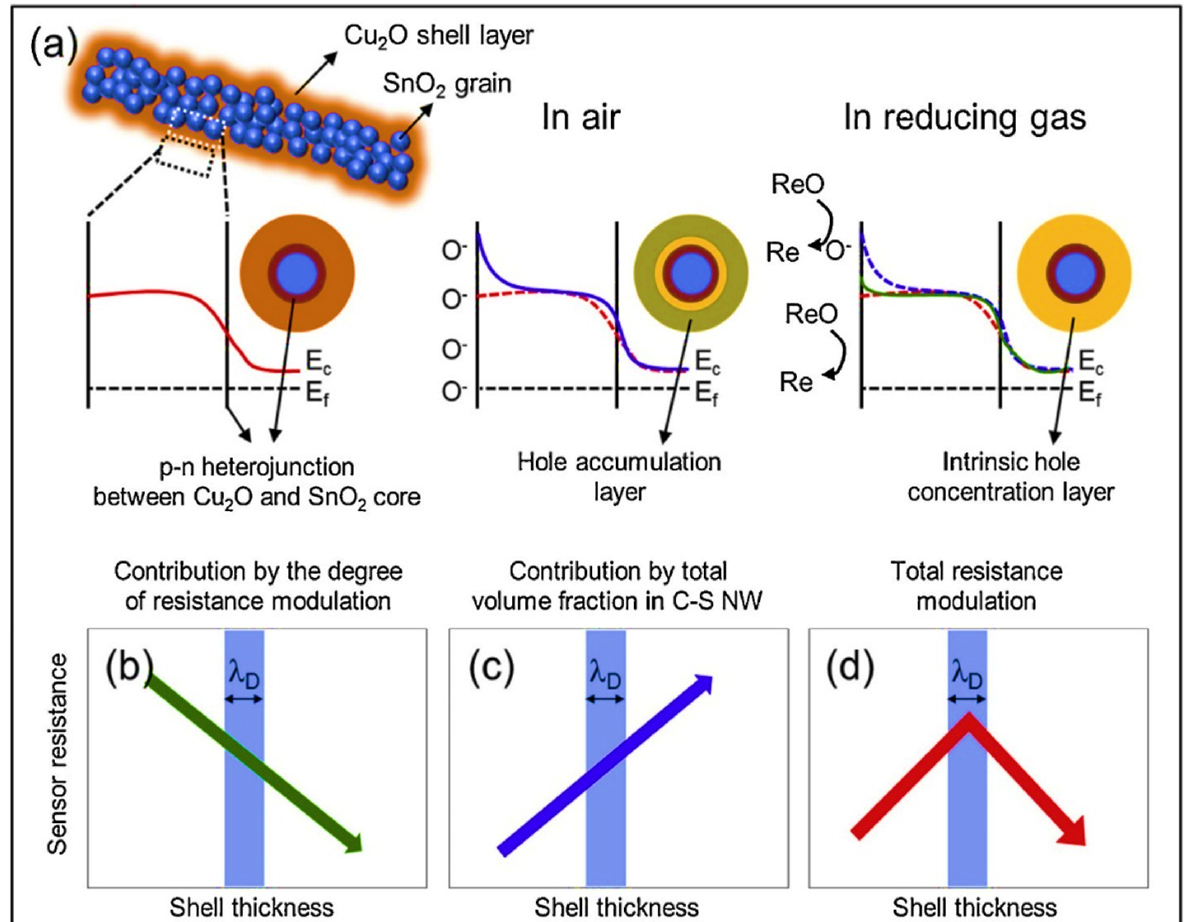
Figure 5. Schematic representation of the gas-sensing mechanisms of the SnO 2 -Cu 2 O C-S NF sensors. ( a ) Hole concentration profile and ( b – d ) variation in sensor resistance due to different contributions. Reproduced from [75] with the permission of Elsevier.